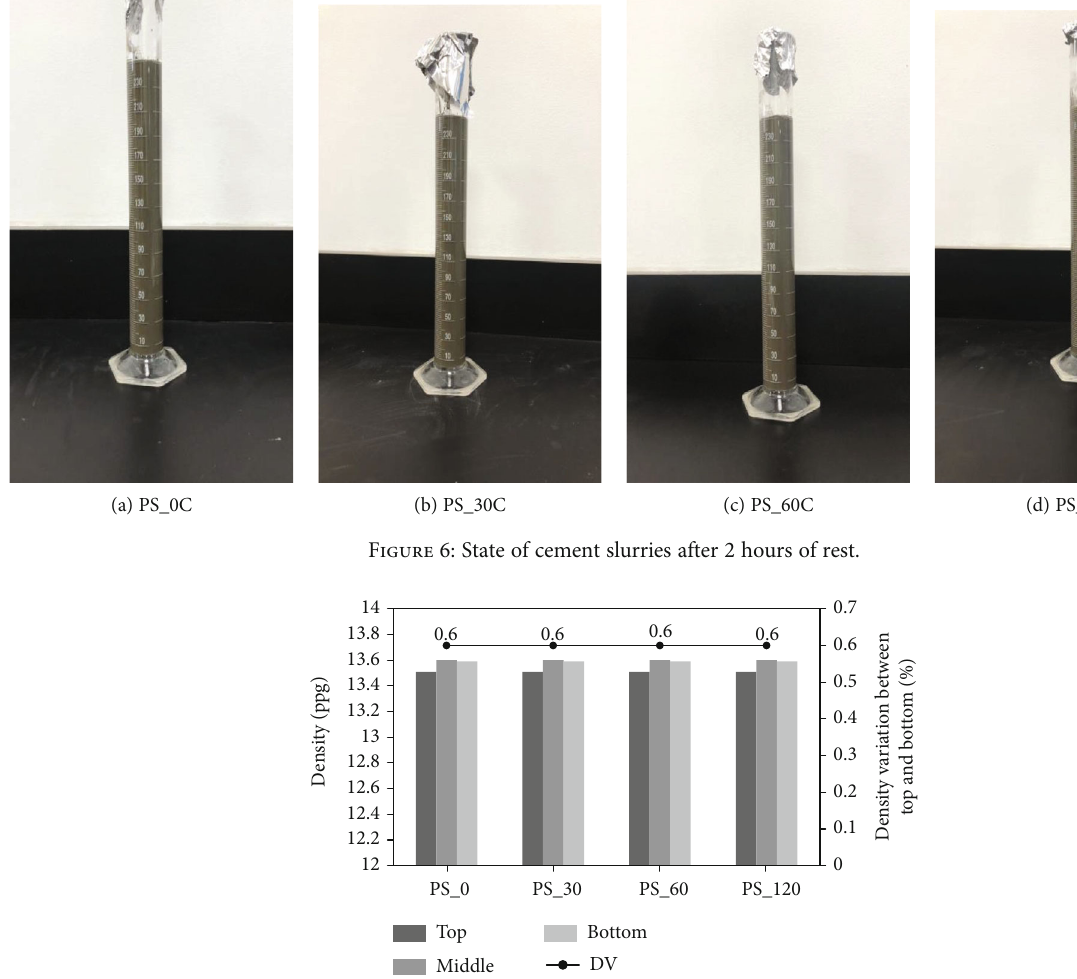
Bottom Figure 7: Density variation.